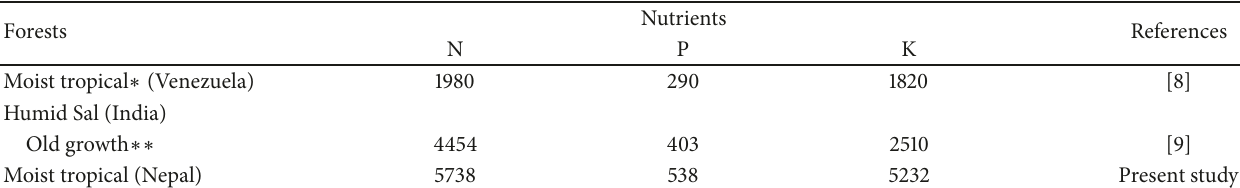
Table 14: Comparison of nutrient storage (kg ha – 1 ) in vegetation of some tropical forests of the